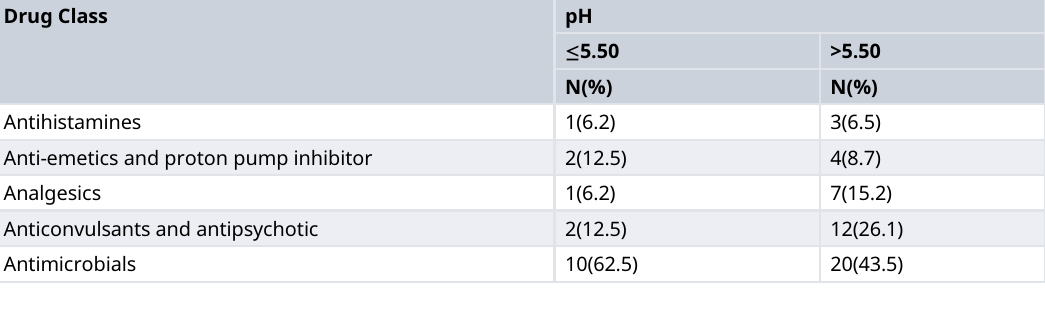
Table 6. Comparison of mean percentage sugar content and total sugar content with critical potential of hydrogen